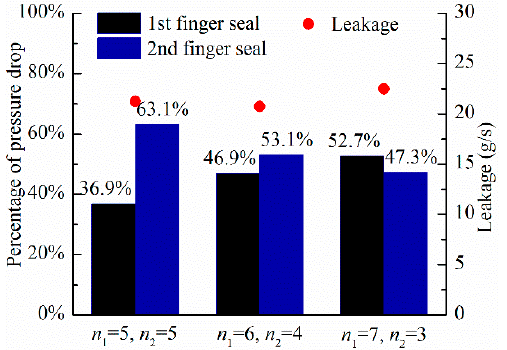
Figure 20. Effect of number of finger elements of each 1SFS on the inter-stage pressure drop characteristics.